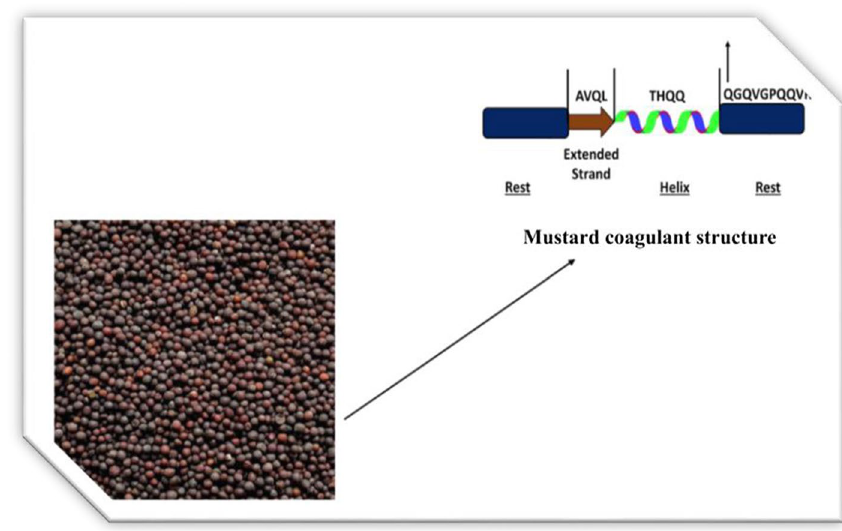
Fig. 6 Mustard seeds as